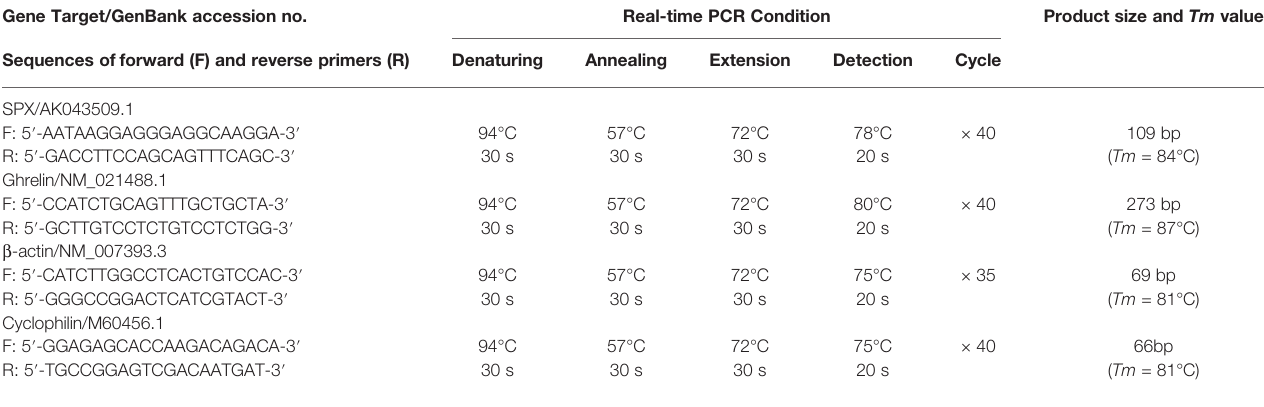
TABLE 1 | Primer sequences and PCR conditions for real-time PCR assays in mouse. Gene Target/GenBank accession